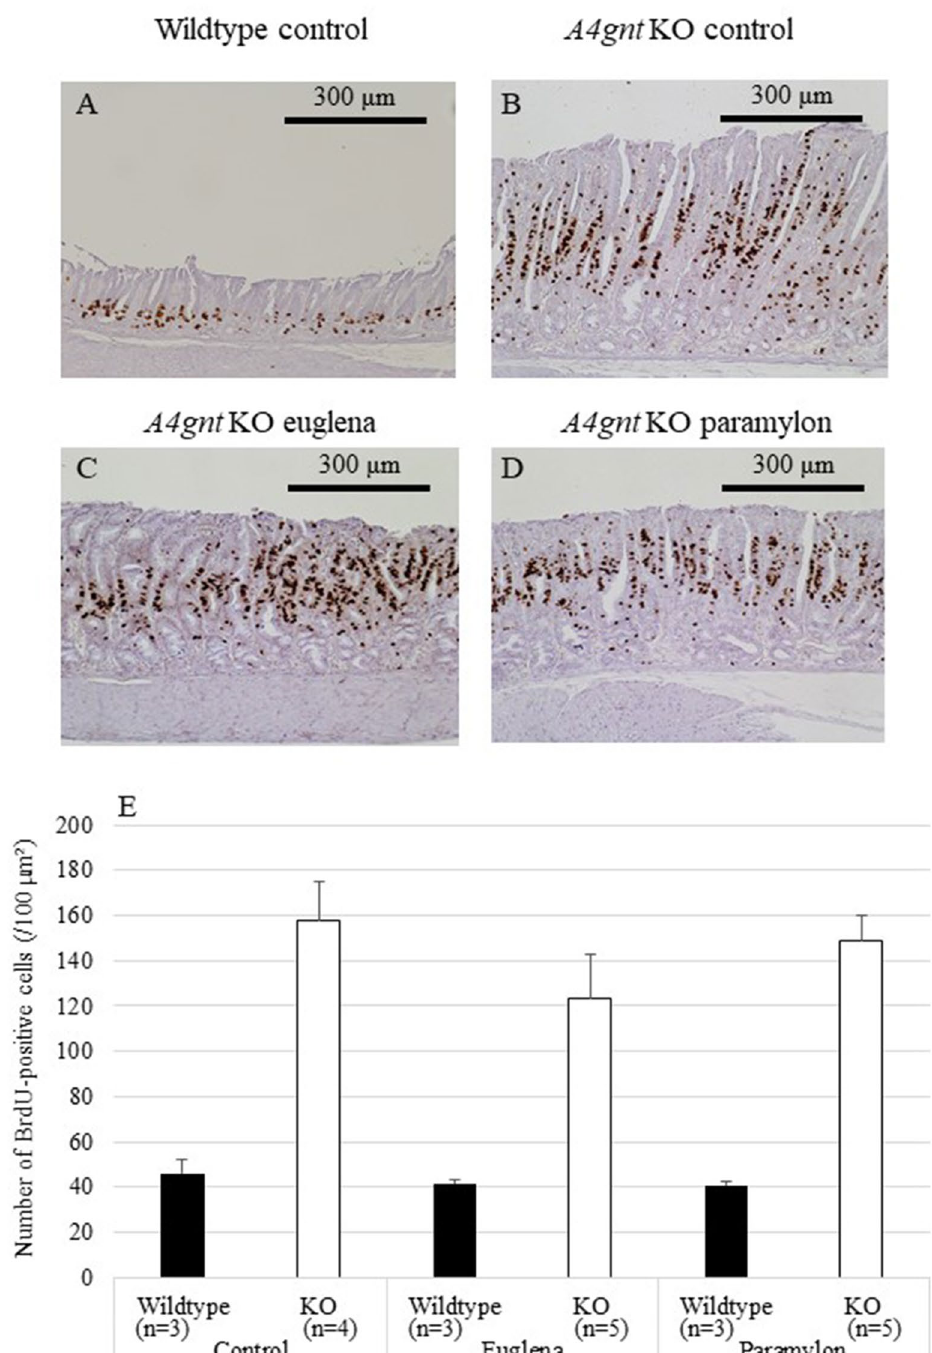
Figure 4. Numbers of BrdU-positive cells in gastric mucosa of A4gnt KO and wildtype mice. ( A ) Wildtype mouse administered saline. ( B ) A4gnt KO mouse administered saline. ( C ) A4gnt KO mouse administered 50 mg/day of Euglena . ( D ) A4gnt KO mouse administered 50 mg/day of paramylon. BrdU-positive cells were stained brown by diaminobenzidine tetrahydrochloride. ( E ) Mean ± SD of numbers of BrdU-positive cells in pyloric mucosa. The mean numbers of BrdU-positive cells in gastric mucosa of A4gnt KO mice was significantly more than that of wildtype mice. Administration of Euglena and paramylon did not affect the numbers of these